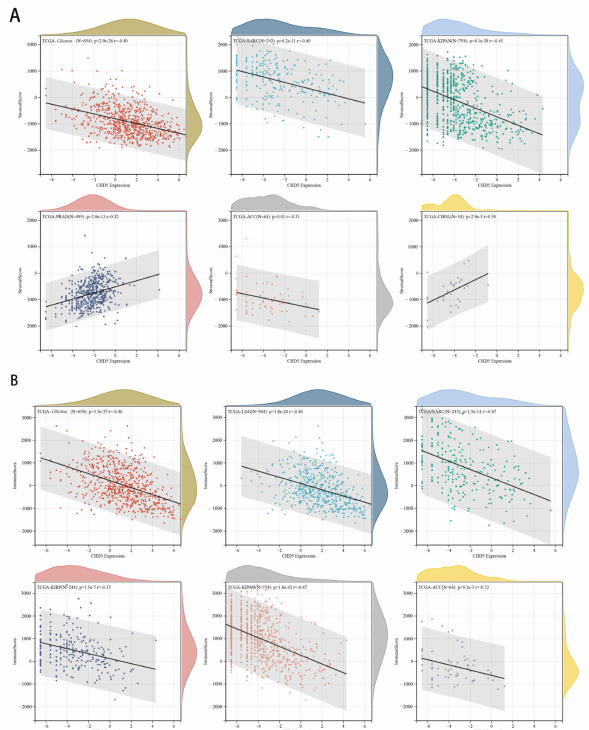
Figure 5. Relationship between CHD5 expression and tumor microenvironment factors. ( A ) CHD5 expression was negatively correlated with the stroma scores in Glioma, SARC, KIPAN, and ACC, and was positively correlated with the stroma scores in PRAD and CHOL. ( B ) CHD5 expression was negatively correlated with the immune scores in Glioma, LGG, SARC, KIRP, KIPAN and